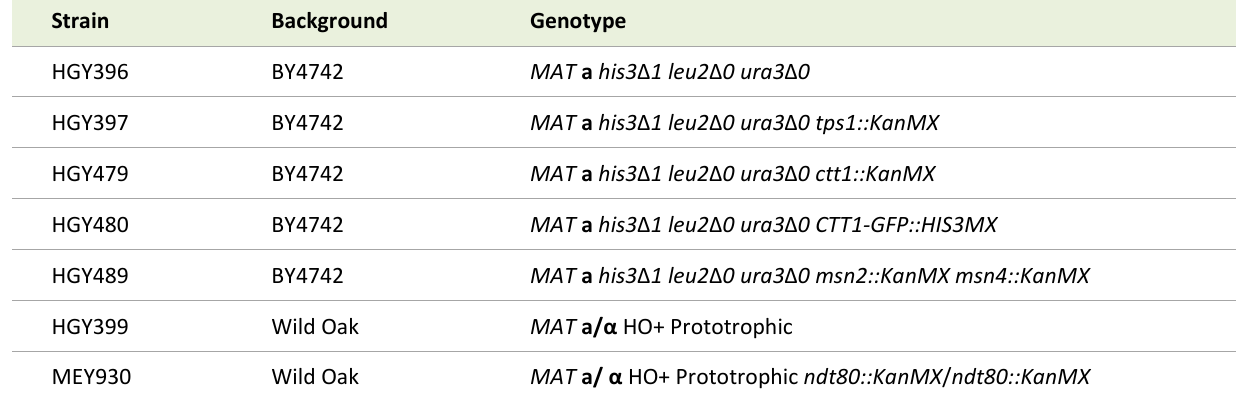
TABLE 1. Strains used. Strain Background